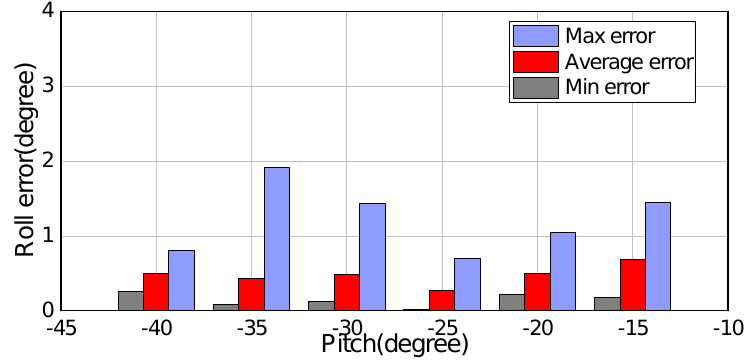
Figure 9. Errors in roll angle at different pitch angles.